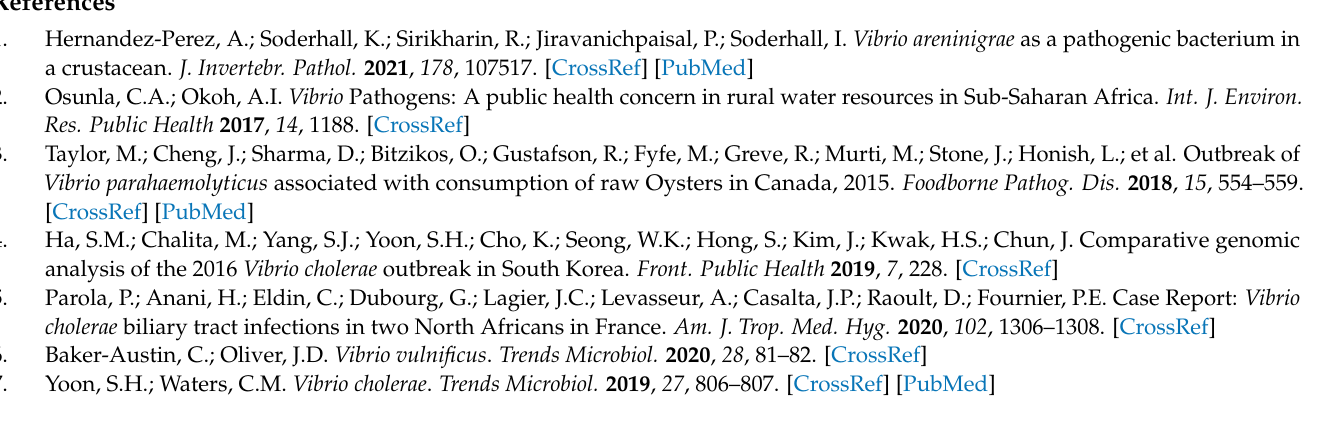
Table S3: Stress-related differentially expressed genes screened by V. brasiliensis cultured in 7% NaCl. (Screening criteria: Abs (log2FC) ≥ 1, p < 0.05), Table S4: Differentially expressed sigma factors of V. brasiliensis cultured with different NaCl concentrations in transcriptome